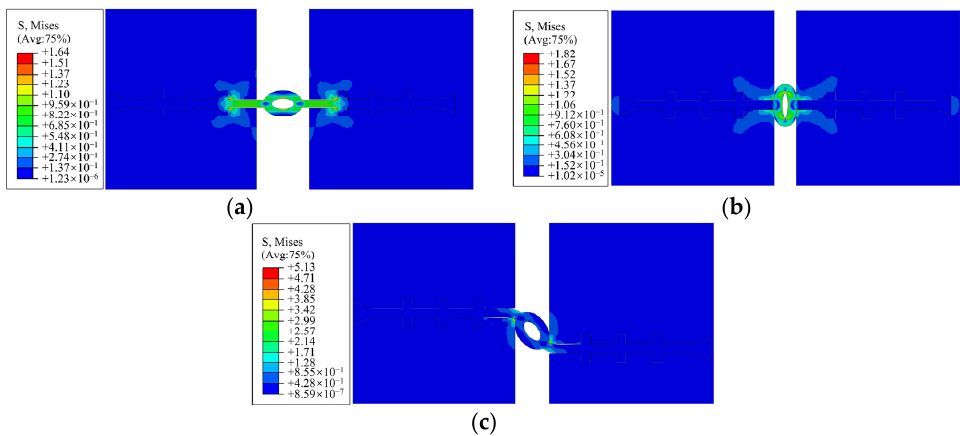
Figure 11. Condition 1 von Mises stress cloud diagram (unit: MPa). ( a ) 1 − 1 stress cloud diagram. ( b ) 1 − 2 stress cloud diagram. ( c ) 1 − 3 stress cloud diagram.